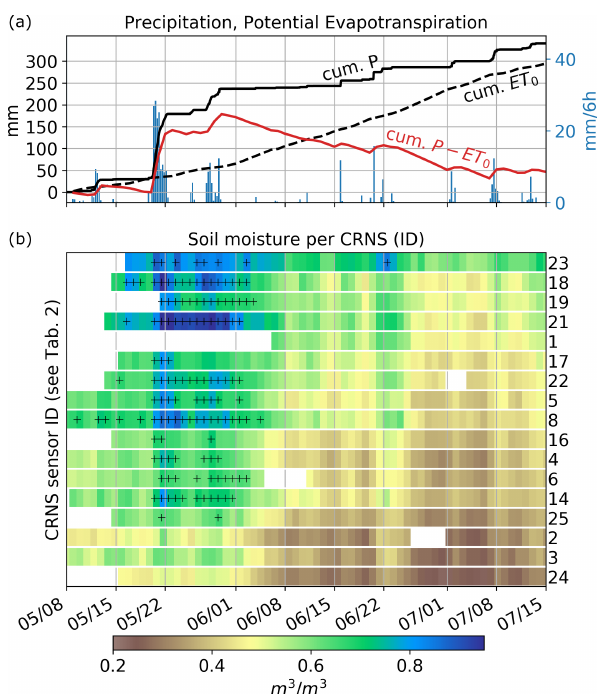
Figure 5. Time series of precipitation, reference evapotranspiration, and estimated soil water content. (a) Cumulative values of precip- itation P (mm), reference evapotranspiration ET 0 (based on FAO, 1998, in mm), and the difference P − ET 0 (in mm); the precipitation depth (mm) obtained at 6h intervals is shown as blue bars. (b) Soil moisture θ(N i ) as estimated for each CRNS sensor i ; rows are ar- ranged from top to bottom in order of decreasing average soil water content during the last week of the campaign (8–15 July). A white space indicates a period of missing data; black + signs indicate pe- riods in which the apparent volumetric soil moisture exceeded the soil porosity, probably due to